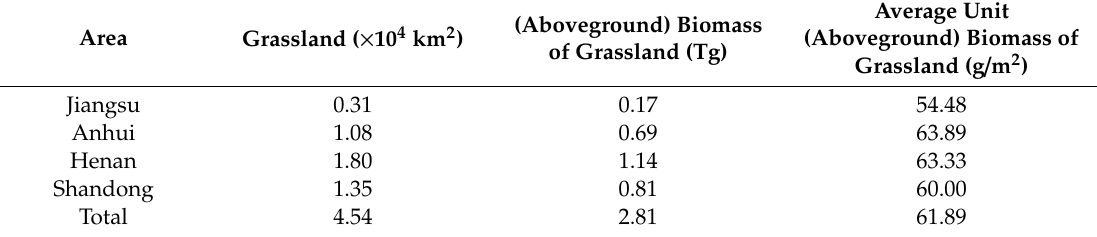
Table 3. The calculation of the average unit (aboveground) biomass of grassland of Xuzhou [55].